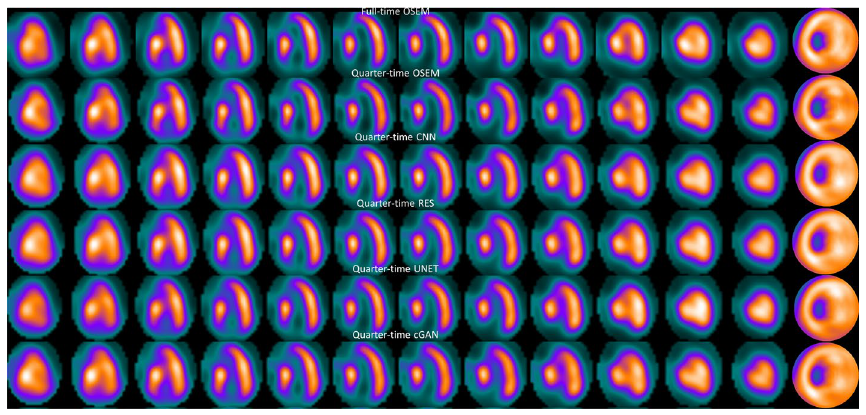
Fig. 5 Example quarter time long axis slices and polar plot (rightmost column) of a rest study with 70% deep defect